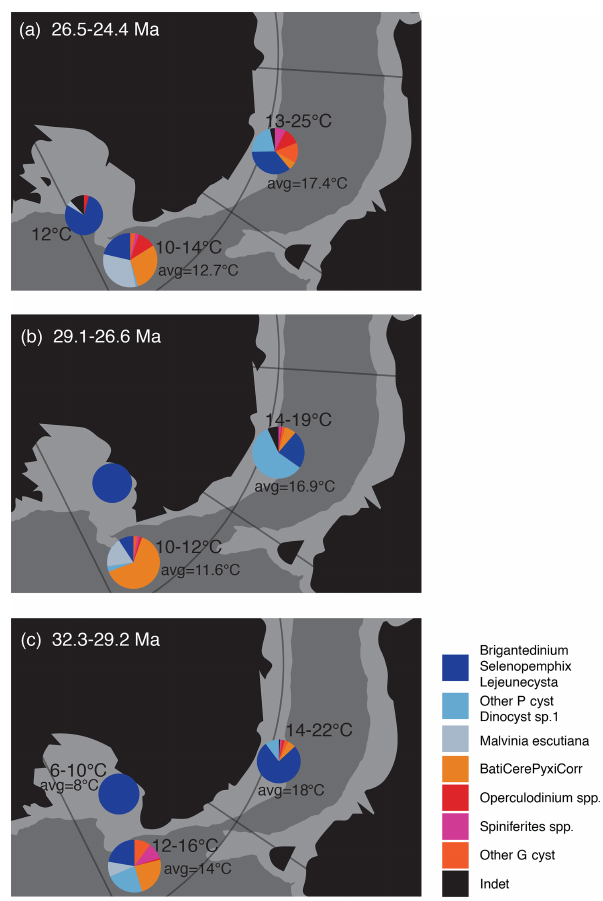
Figure 5. Synthesis of sea surface temperature and dinocyst assem- blage changes between the early (c) , mid (b) and late Oligocene (a) in the Ross Sea (CRP, DSDP Site 270), offshore of Cape Adare (this study, DSDP Site 274) and Wilkes Land margin (Site U1356). The pie charts visualise the dinocyst assemblage composition at the respective sites (see legend). Dinocyst assemblage data from the Wilkes Land margin, U1356, are from Bijl et al. (2018a, b) for panels (a) – (c) . Dinocyst assemblage data from the Ross Sea are gathered from DSDP Site 270 (Kulhanek et al., 2019) for panel (a) and from CRP (Houben et al., 2013; Clowes et al., 2016) for panels (b) and (c) . The TEX 86 -SST data from Wilkes Land, U1356, are from Hartman et al. (2018), and 35 TEX 86 -data points were used: 7 in panel (a) , 9 in panel (b) and 19 in panel (c) . In the Ross Sea, there is a lack of TEX 86 -SST data from the mid- Oligocene, but Duncan (2017) presented unpublished TEX 86 data from CIROS-1 (12 TEX 86 -data points), here displayed in panel (c) , and from DSDP Site 270, where only one data point matched our mid-early-Oligocene time slice in panel (a) . All TEX 86 data have been converted to SST using the linear calibration method of Kim et al. (2010) (calibration error of ± 5 . 2 ◦ C). The palaeogeographic position is generated with GPlates (http://www.gplates.org, last ac- cess: 13 June 2016), based on the global plates geodynamic motion model from Müller et al.